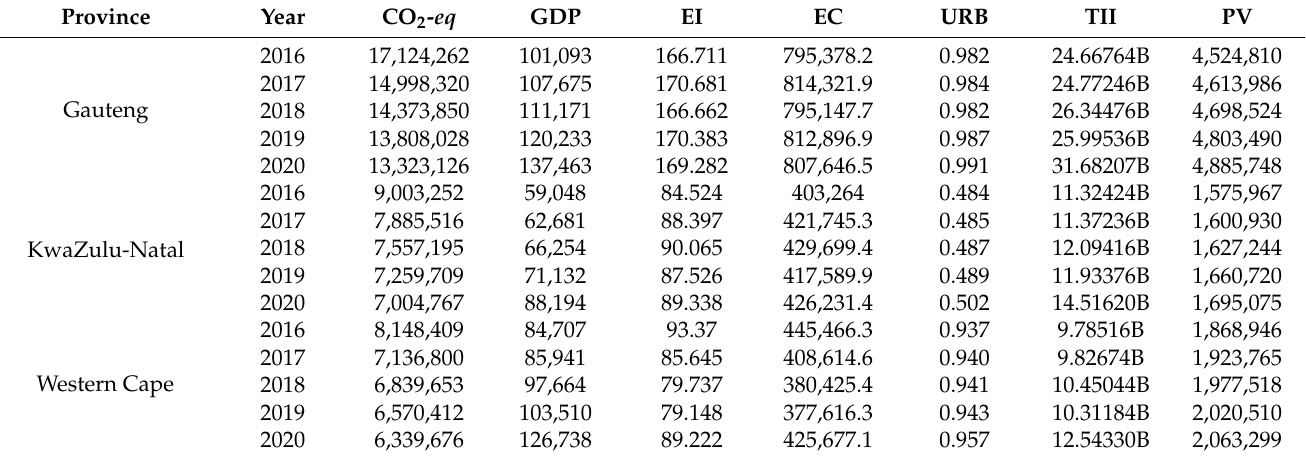
Table 3. Three provincial 5-year panel dataset constructions for South Africa’s transportation